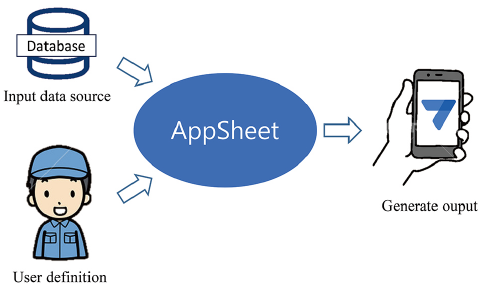
Figure 3. Work process of AppSheet platform